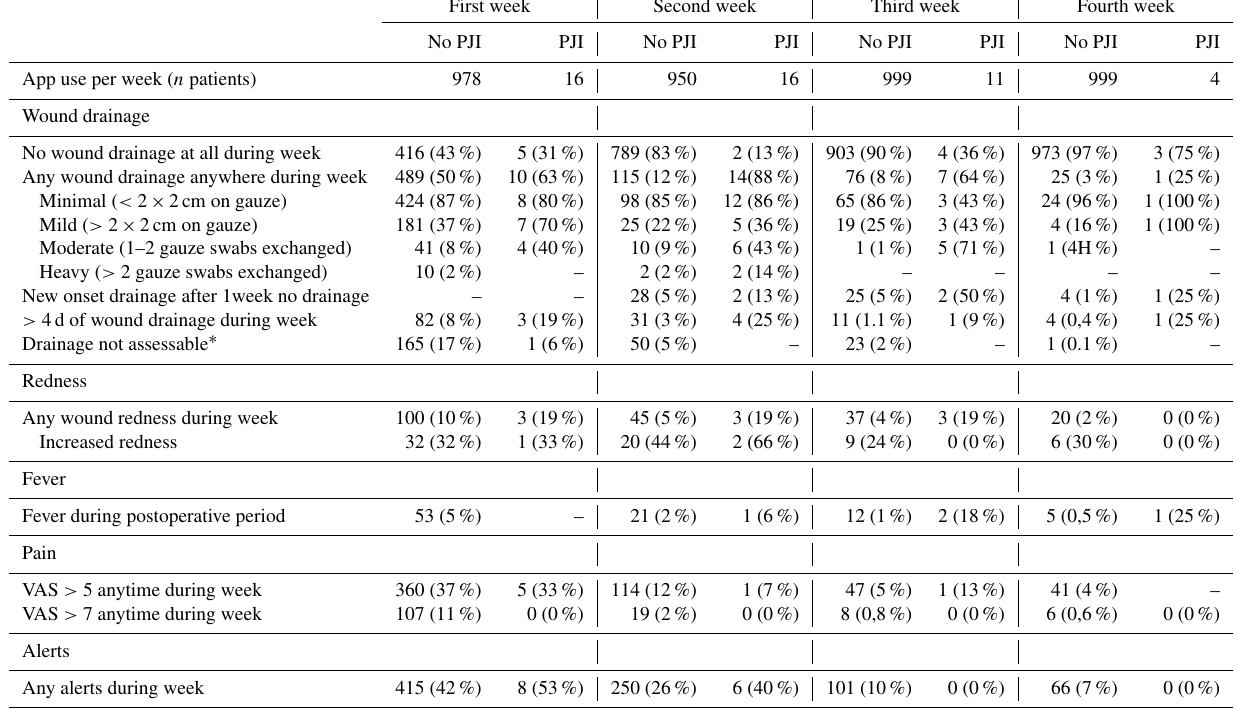
Table 3. Reported postoperative wound drainage in all patients with and without prosthetic joint infection.